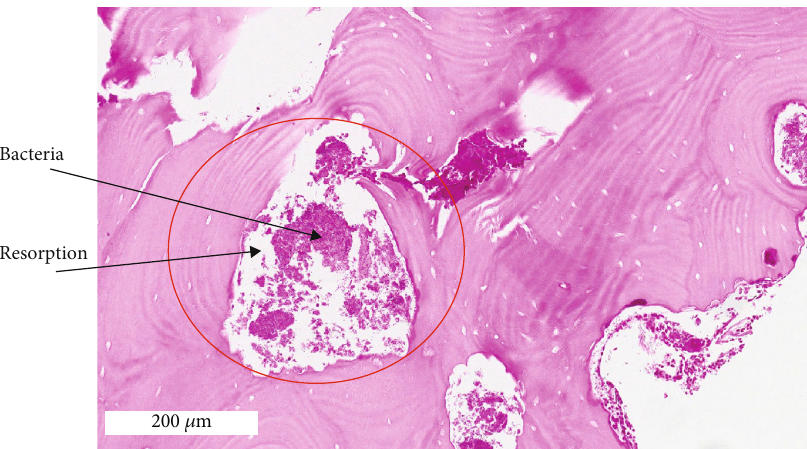
Figure 5: H&E stain showing bacterial invasion in the bone causing resorption. Bacteria (black arrow) and resorption of bone (black stars).